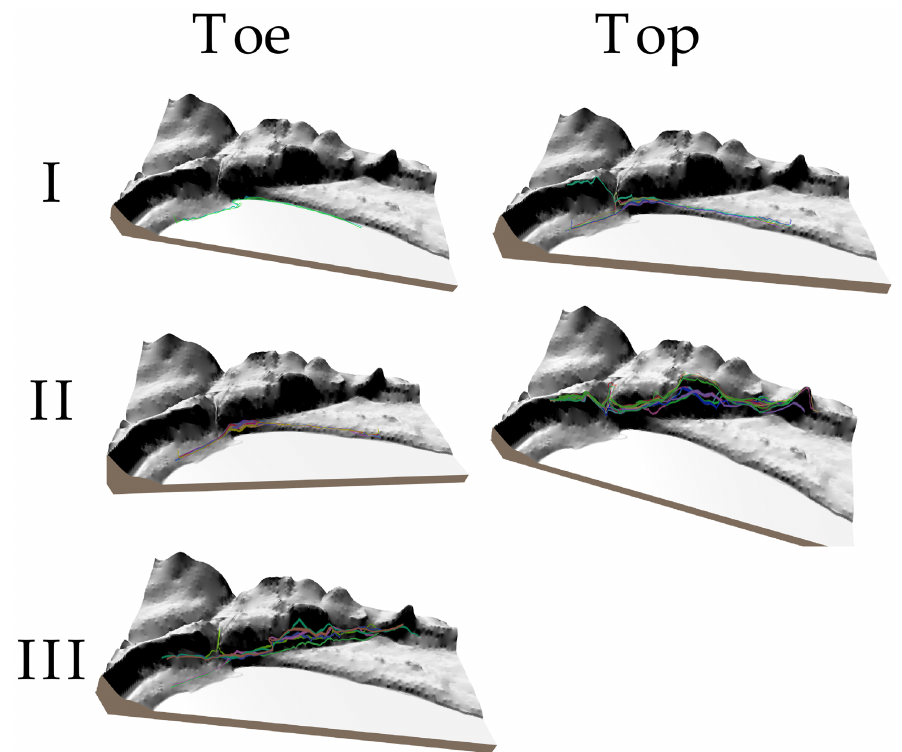
Figure 16. manually digitized cliff top and toe lines (coloured lines) over the DEM for the DG site. DEM colours represent slope (darker colours represent higher slopes). The vertical dimension has been exaggerated 10 times. The roman numbers represent the main clusters of manually digitized lines.